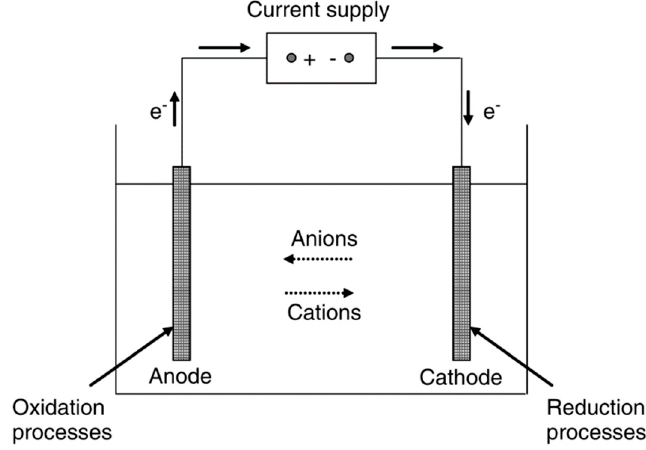
Figure 2. Schematic diagram of electrochemical reactor (Adapted from [25]).